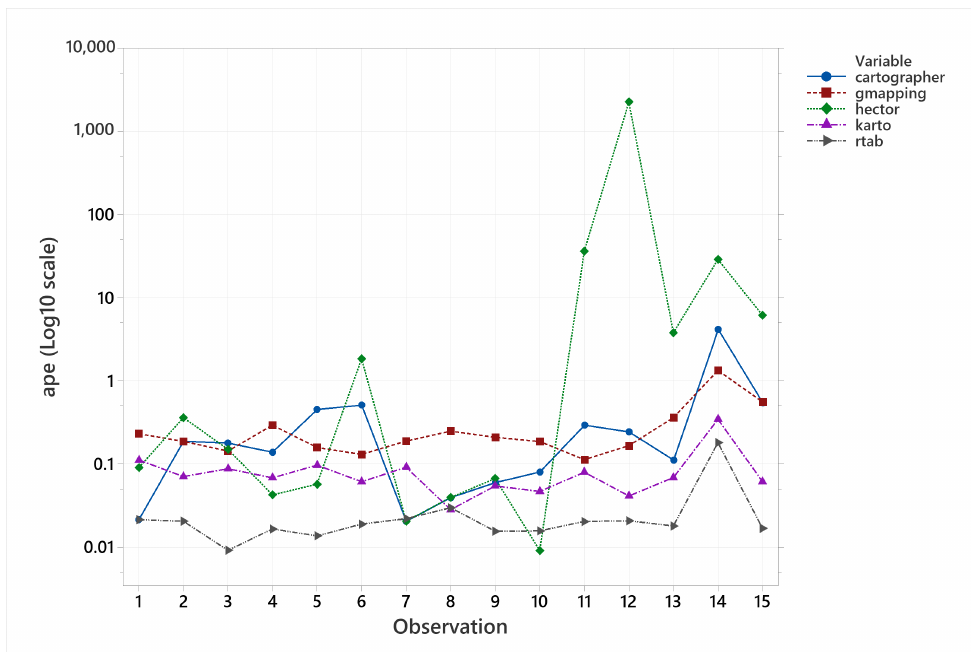
Figure 30. Pose accuracy mean behavior for all the algorithms